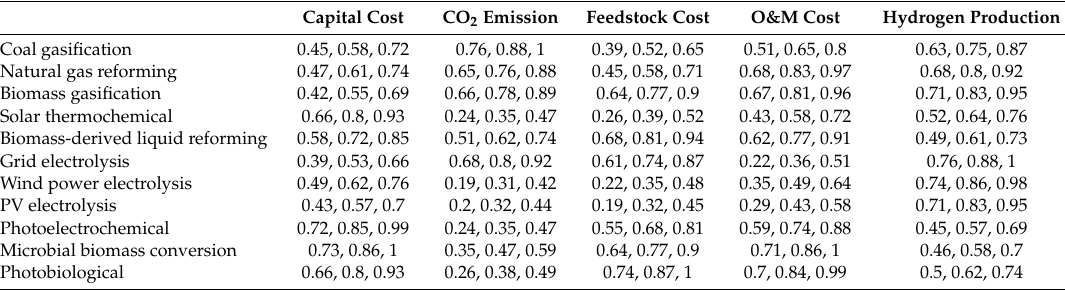
Table 7. Normalized fuzzy decision matrix.